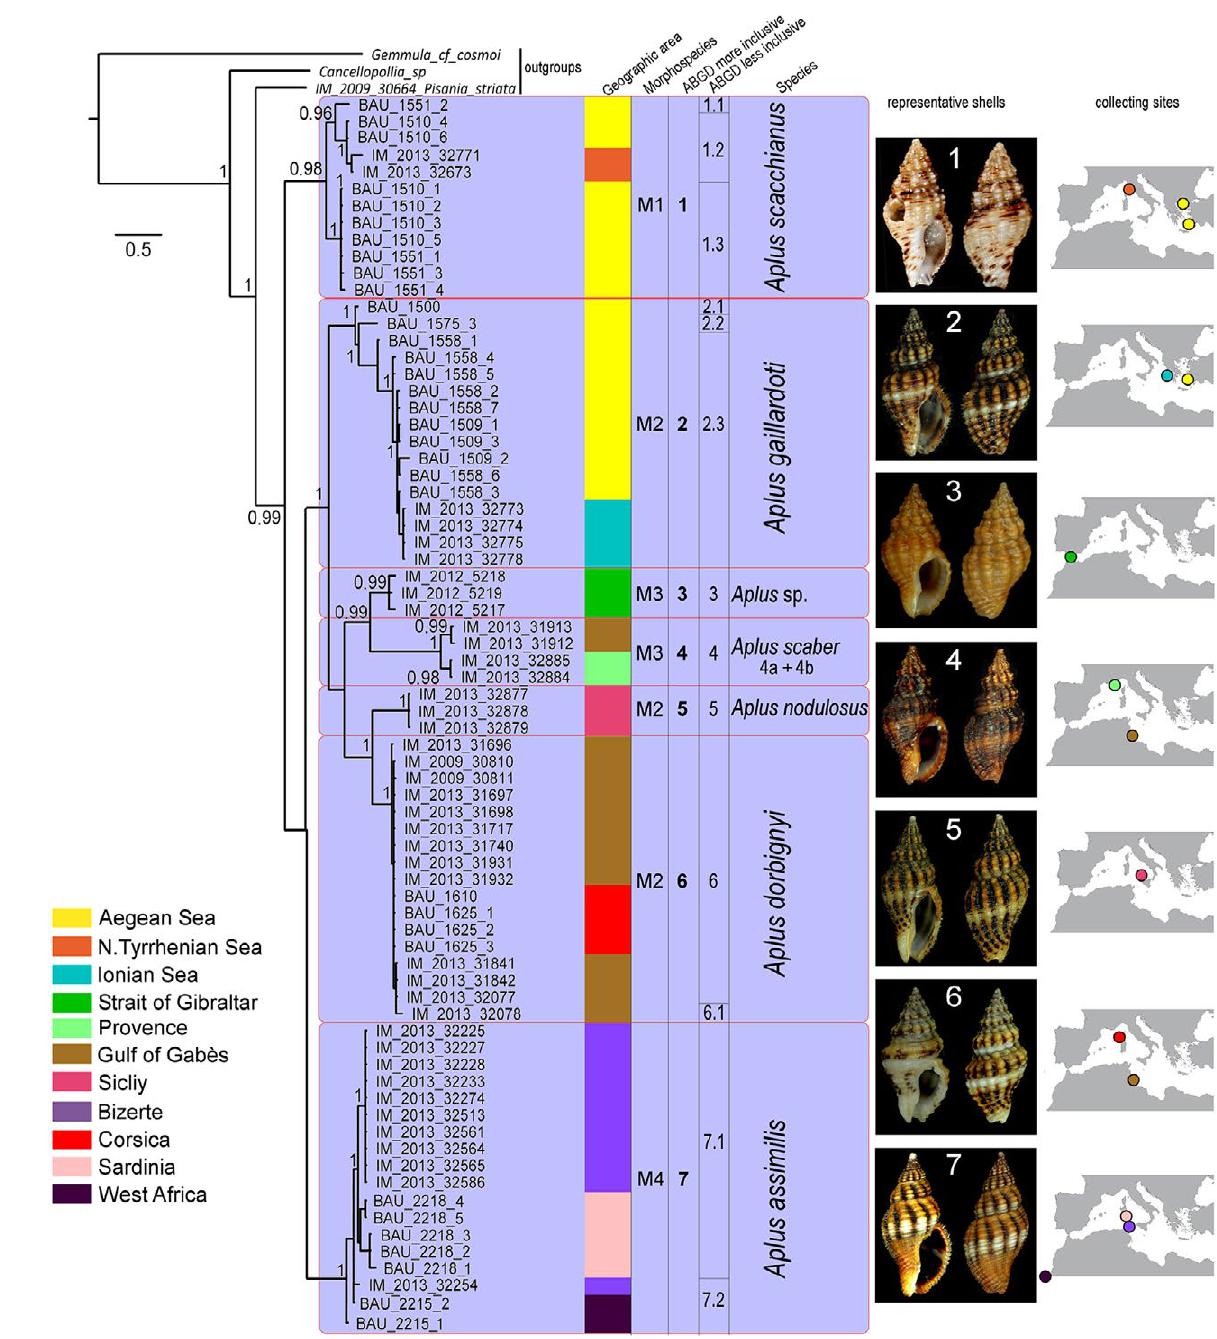
Fig. 2. – Bayesian phylogenetic tree based on the COI alignment (GTR+I+G model of evolution; 5×10 6 generations and 25% burn-in). Num- bers at nodes indicate the Bayesian posterior supports (only values > 0.95 are reported). Morphospecies (M1-M4) indicate the morphological primary identification of the assayed specimens. ABGD more and less inclusive partitions report the MOTUs (1-7 and 1.1-7.2, respectively) as molecularly identified. The shell of one assayed specimen for each of the seven major lineages is illustrated. Colour of collecting areas is also reported in the bars beside the tree and in the circles of the collecting sites on the small